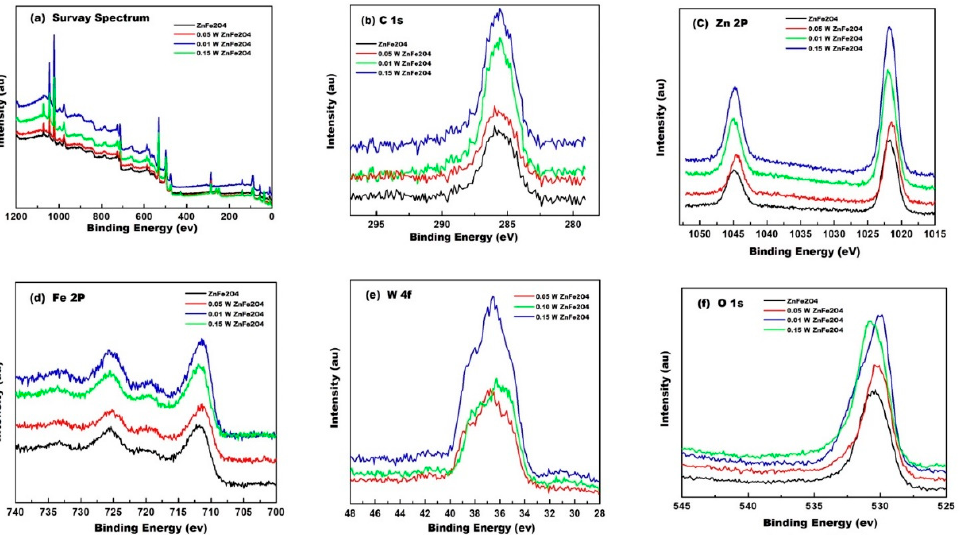
Figure 7. High resolution XPS spectra of ZnFe 2 O 4 , ZnW 0.05 Fe 1.95 O 4 , ZnW 0.1 Fe 1.90 O 4 , and ZnW 0.15 Fe 1.85 O 4 . ( a ) survey spectrum, ( b ) C1s, ( c ) Zn2p, ( d ) Fe2p, ( e ) W4f, and ( f ) O1s.